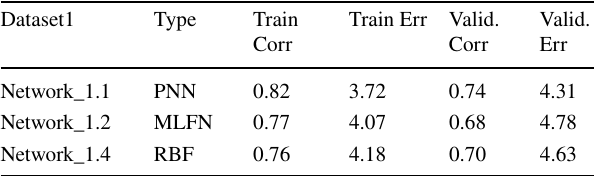
Table 7 Results of evaluation of various networks for the first set of data Dataset1